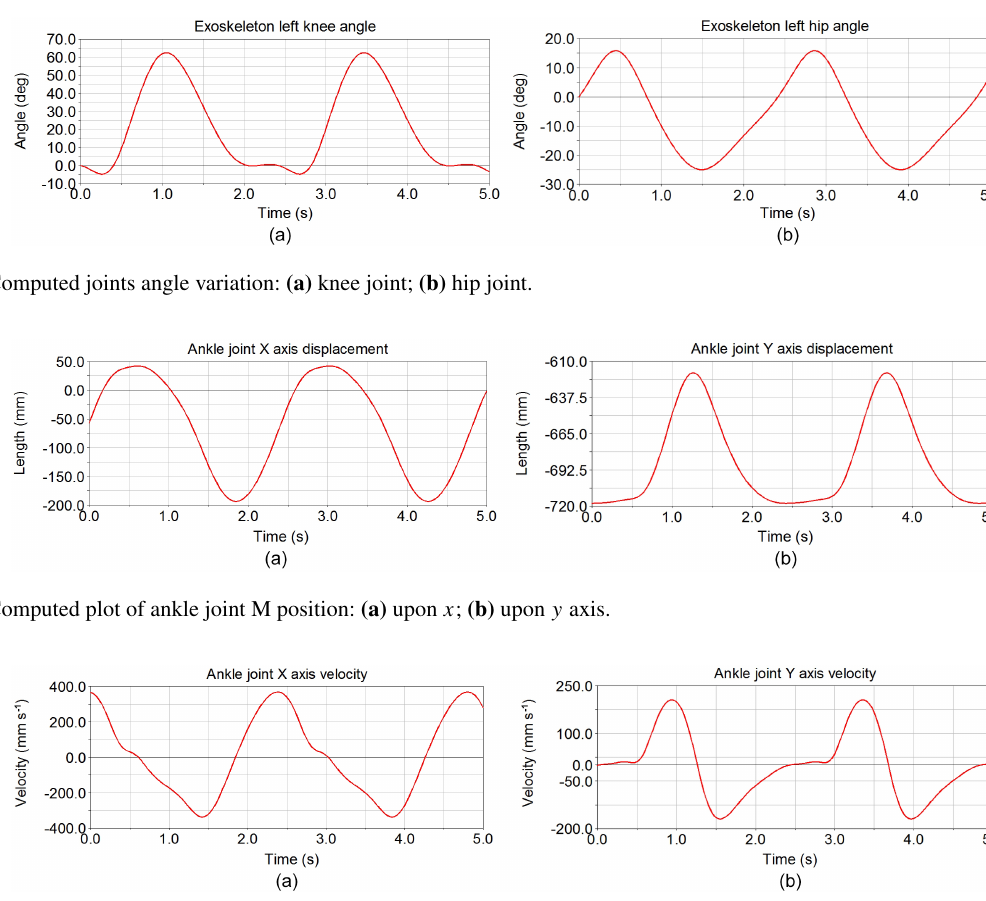
Figure 12. Computed plot of ankle joint M velocity: (a) upon x ; (b) y axis.